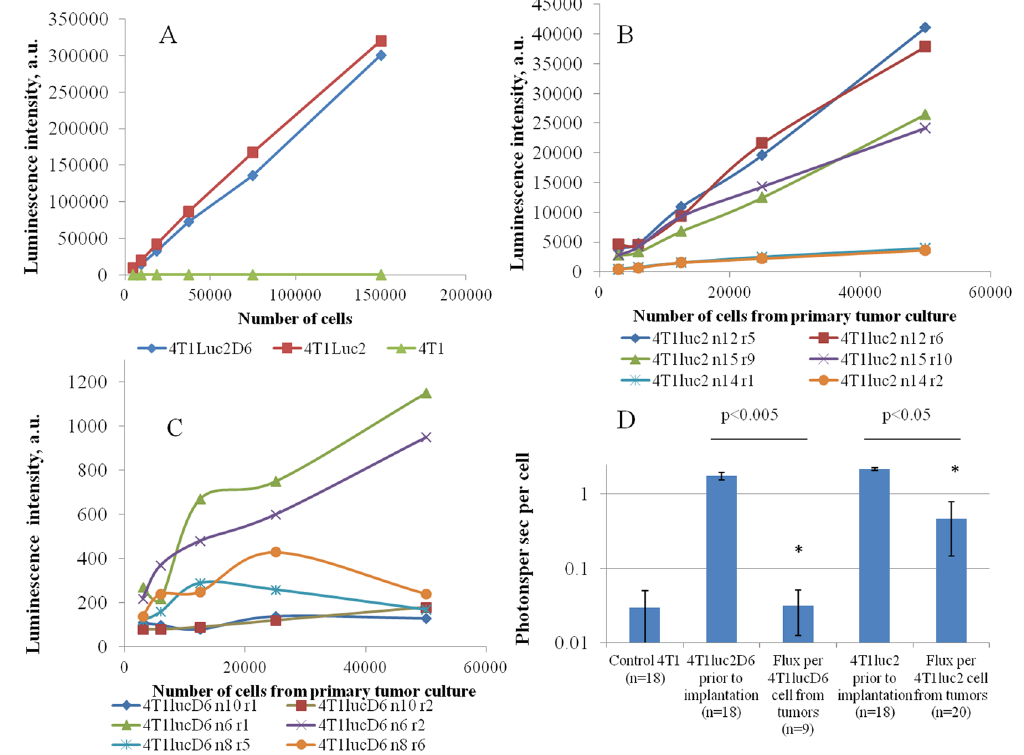
Figure 3. Comparison of the luciferase activity measured as the intensity of luminescence (in arbitrary units a.u.; Enspire, Perkin Elmer) in the original 4T1luc2 and 4T1luc2D6 cell lines and in cell cultures prepared from the 4T1luc2 and 4T1luc2D6 tumors by the experimental end-point. Luciferase activity in the 4T1luc2 and 4T1luc2D6 cells prior to implantation ( A ); Luciferase activity in primary cell cultures prepared from tumors formed in BALB/c mice by implantation of 4T1luc2D6 (n = 3; 6 tumors) ( B ) or 4T1luc2 cells (n = 3; 6 tumors) ( C ); Recalculation of the average luciferase activity per cell with STDV ( D ). Individual tumors are coded by the cell line, mouse and tumor numbers, for example “4T1luc2D6 n10 r1” designate a tumor caused by implantation of cell line 4T1luc2D6 into mouse No. 10 and refer to sample No. 1 from one of the tumors. Curves in panels B and D show dependence of luciferase activity on the number of cells used in the assay; data represent